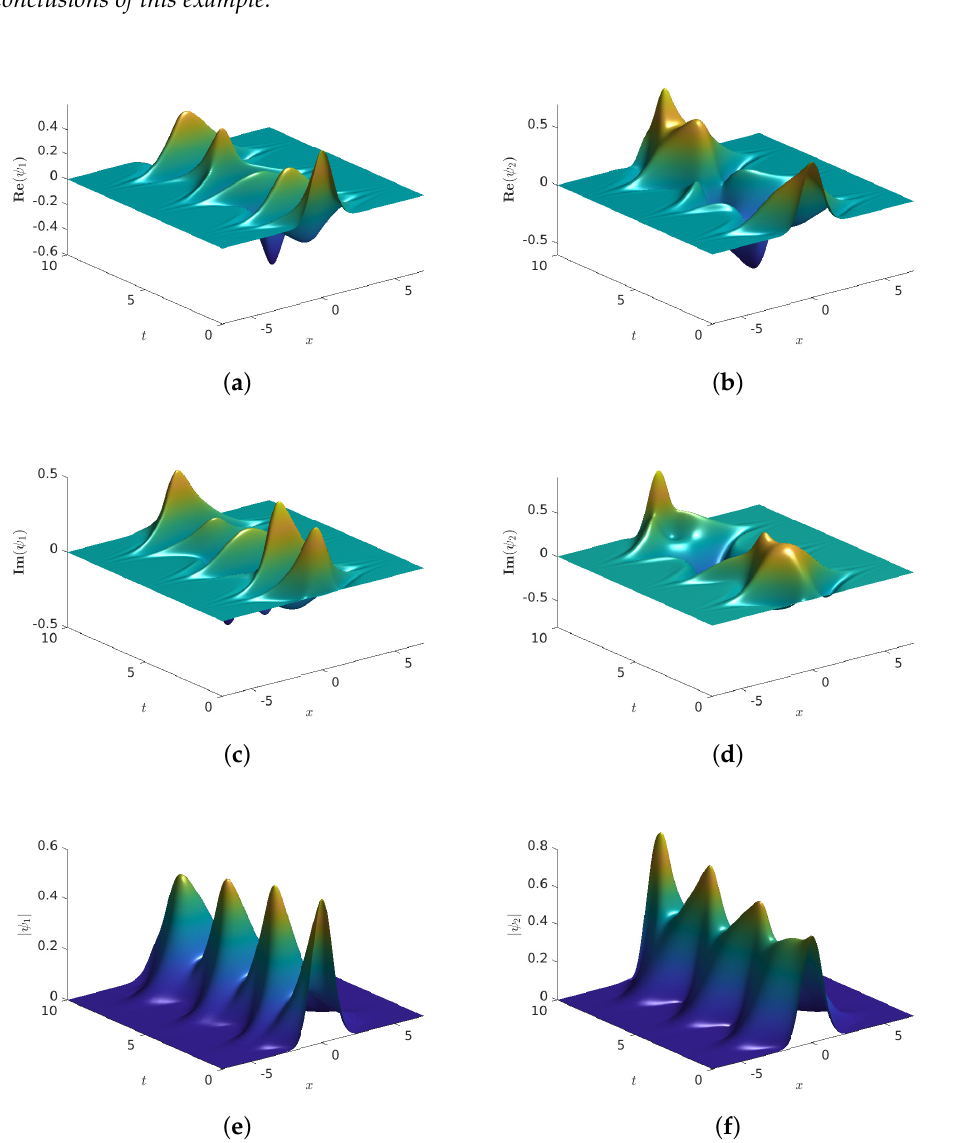
Figure 1. Numerical approximations to the solutions of Equation (4) versus x and t , using the constants of Table 1. The graphs were obtained using the finite-difference method of Equation (16) with T = 10, α 1 = α 2 = 2, τ = 0.01, and h − 1 = 0.1. We also let V ( x ) = 1 1 √ exp ( − x 2 ) , for each x ∈ Ω . The graphs provide ( a ) Re ( ψ 1 ) , ( b ) Re ( ψ 2 ) , ( c ) Im ( ψ 1 ) , ( d ) Im ( ψ 2 ) , π ( e ) | ψ 1 | , and ( f ) | ψ 2 |